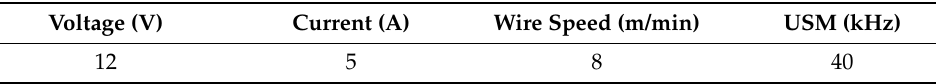
Table 5. Machining Conditions.